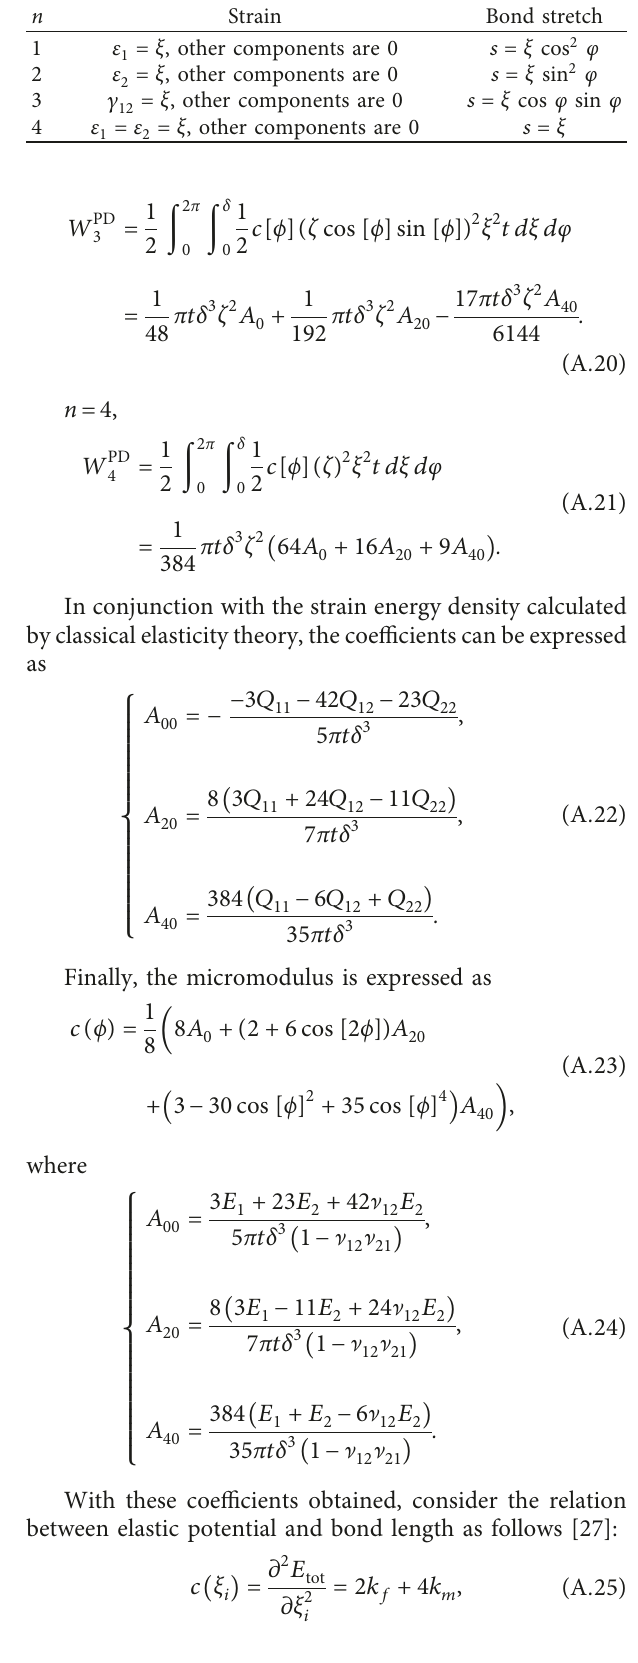
Table 3: Four strain states and the corresponding